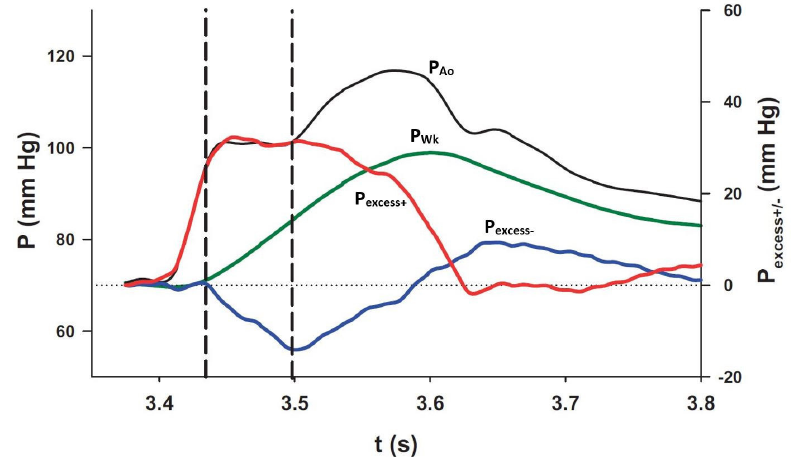
and P (black and green lines, respectively; Ao Wk and P (red and blue lines, respectively; scale on the right). The plateau excess+ excess− is exactly equalled by the Wk